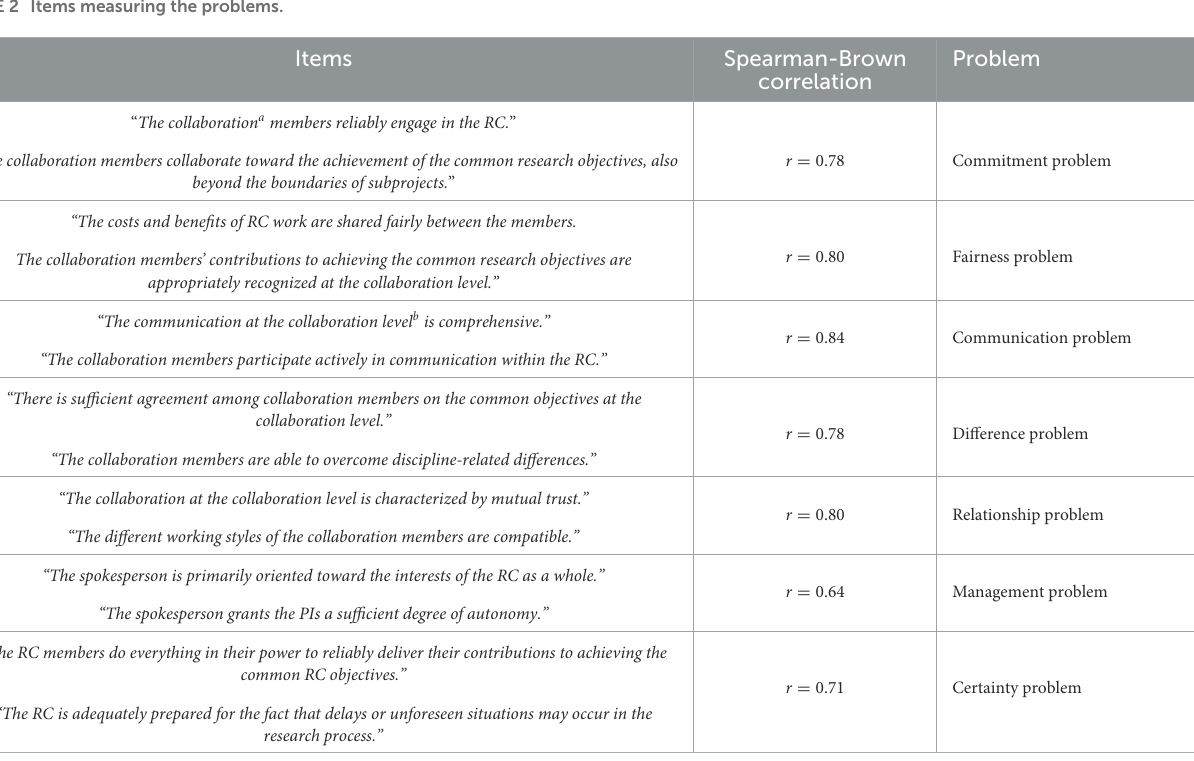
TABLE 2 Items measuring the